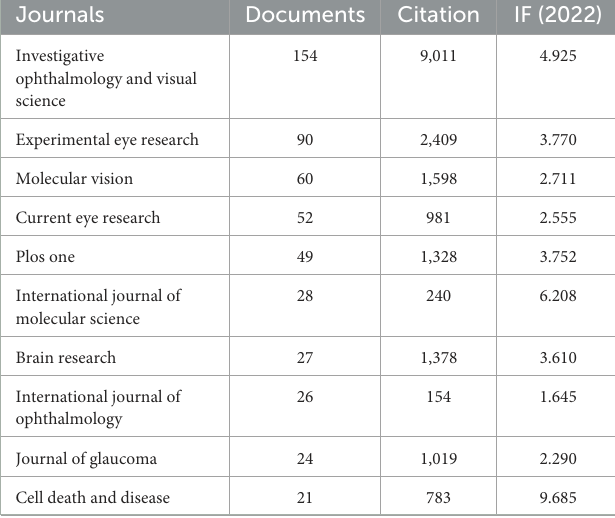
TABLE 2 The top 10 journals for publications.